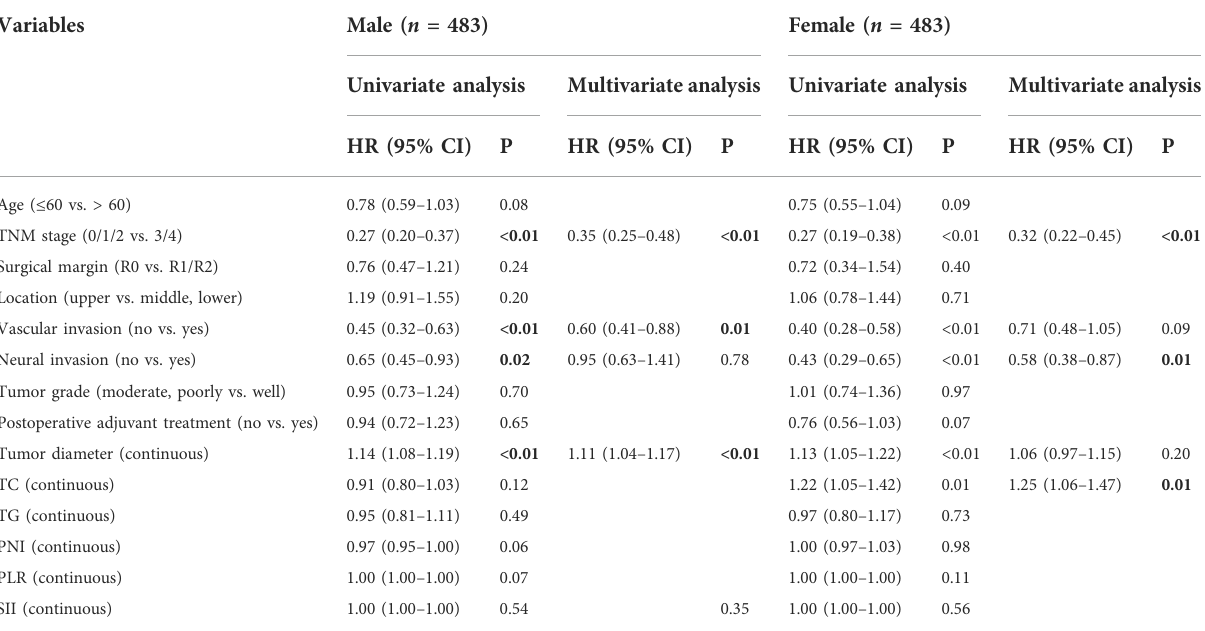
TABLE 5 Univariate and multivariate analysis of overall survival in ESCC patients strati fi ed by gender after